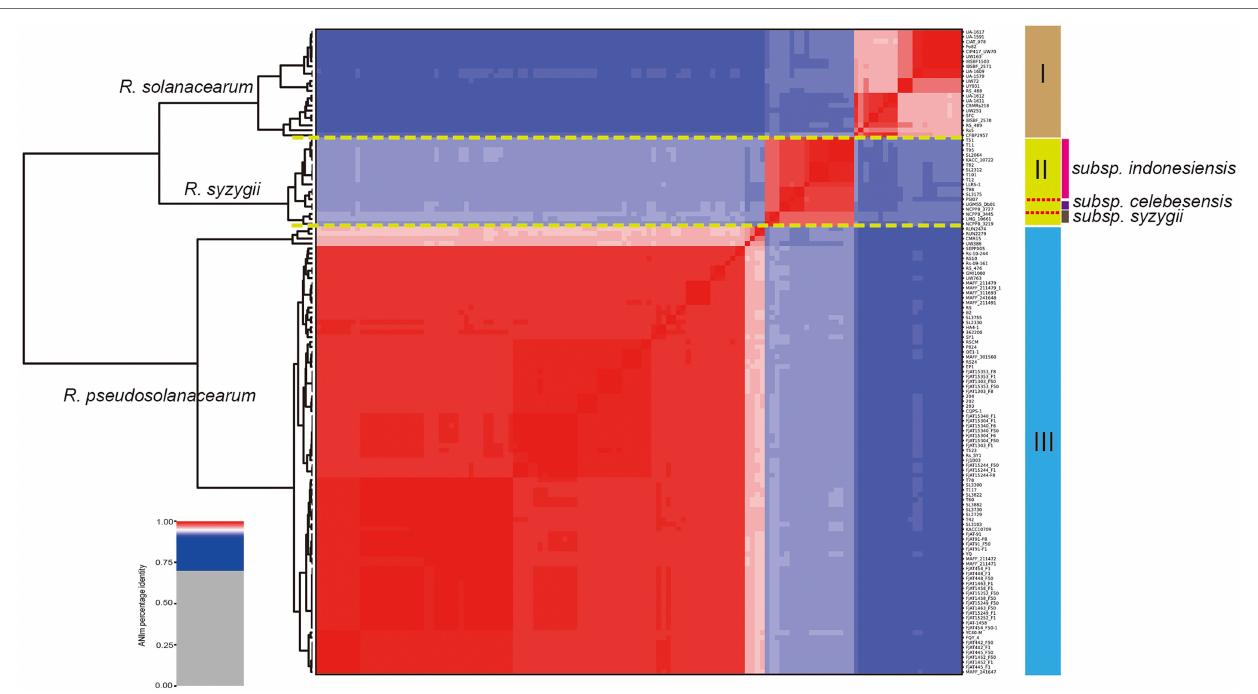
FIGURE 1 | Taxonomic classification of Ralstonia solanacearum species complex (RSSC) based on comparison at the whole genome level. Phylogenetic tree based on blast all vs. all of 131 RSSC strains, which could be divided into three species, and the species names were labeled on the front of each branch (numbers I, II, and III were marked in the right). Three stains belong to the subspecies of R. syzygii subsp. indonesiensis were marked with three different colors near their